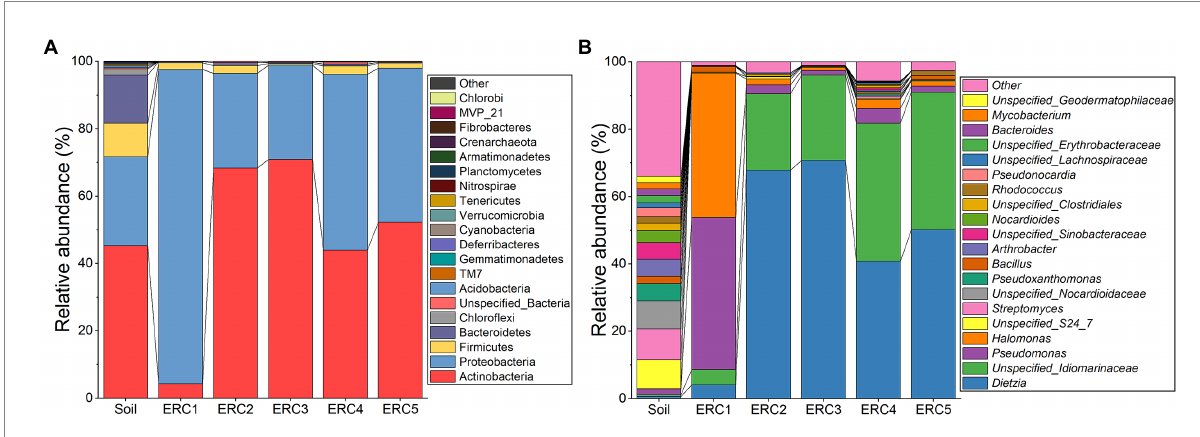
FIGURE 1 Microbial community composition during enrichment culture at (A) phylum and (B) genus levels (relative abundance top